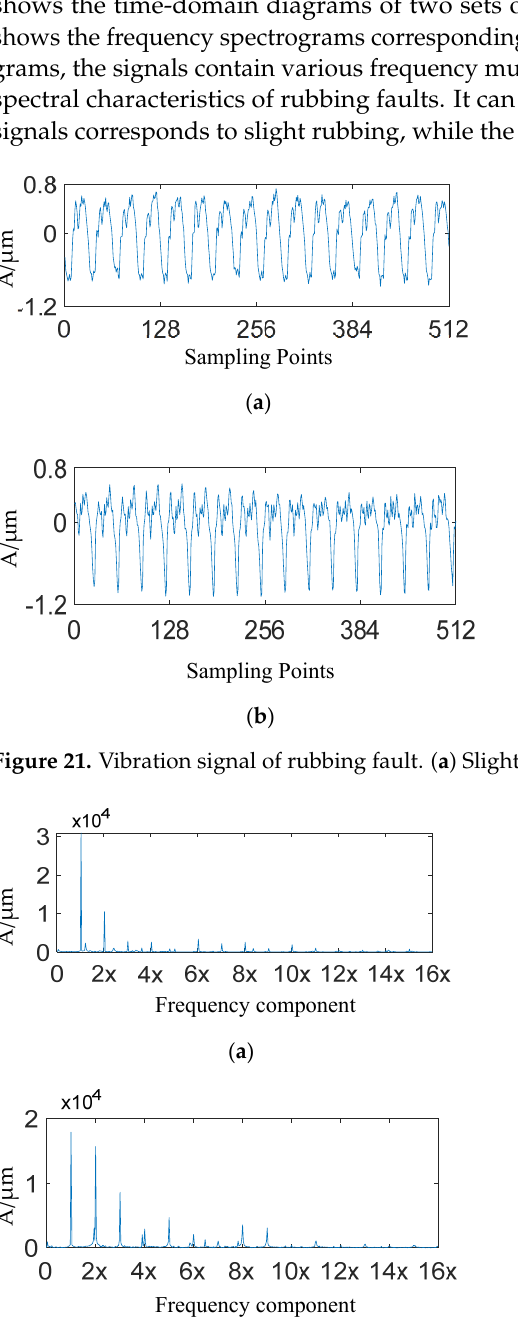
Figure 20. Rotor radial rubbing fault simulation.